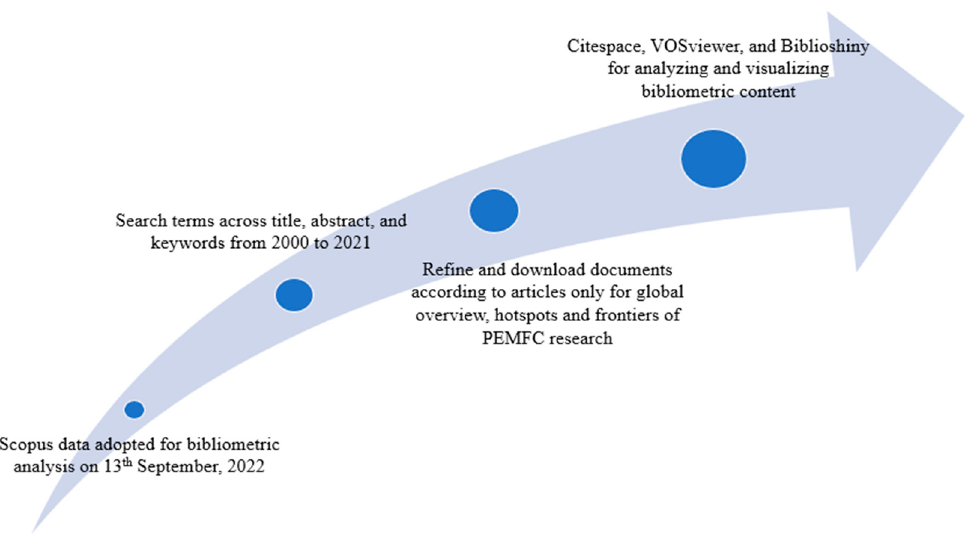
Figure 13. Methodology adopted for retrieving and final dataset on PEMFC research.